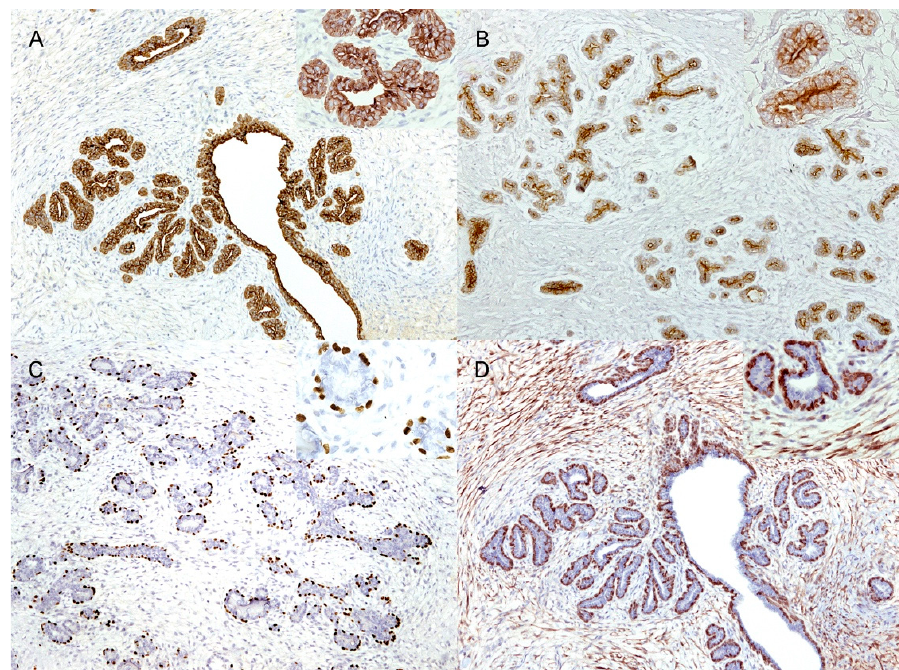
Figure 2. Immunohistochemical features of feline mammary fibroadenoma. ( A ) Neoplastic cells of ducts and tubules showing diffuse cytoplasmic positivity for pancytokeratin (10×). Inset: higher magnification (40×); ( B ) Polygonal ductal and tubular neoplastic epithelial cells exhibiting diffuse cytoplasmic immunolabelling for cytokeratin 19 (10×). Inset: higher magnification (40×); ( C ) Nuclear p63 positivity observed in basally located elongated cells consistent with myoepithelial cells (10×). Inset: higher magnification (40×); ( D ) Intra ‐ and interlobular stromal cells, as well as ductal and tubular basally ‐ located elongated cells showing cytoplasmic immunolabelling for calponin (10×). Inset: higher magnification (40×).